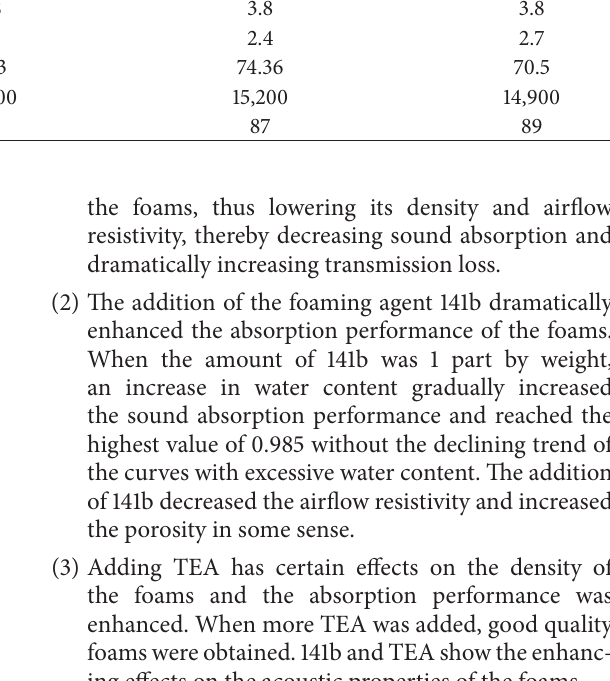
Figure 12: Curves of absorption coefficients of the PU foams with added triethanolamine. (a) Group 1 with 3.8 parts by weight, (b) Group 2 with 4.1 parts by weight, (c) Group 3 with 4.4 parts by weight, and (d) Group 4 with 4.7 parts by